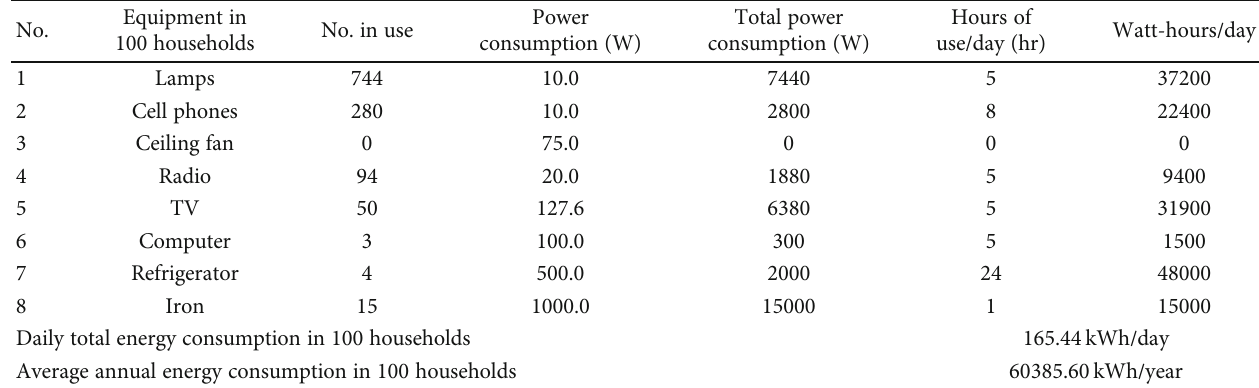
Table 2: Community electrical loads and their daily load pro fi